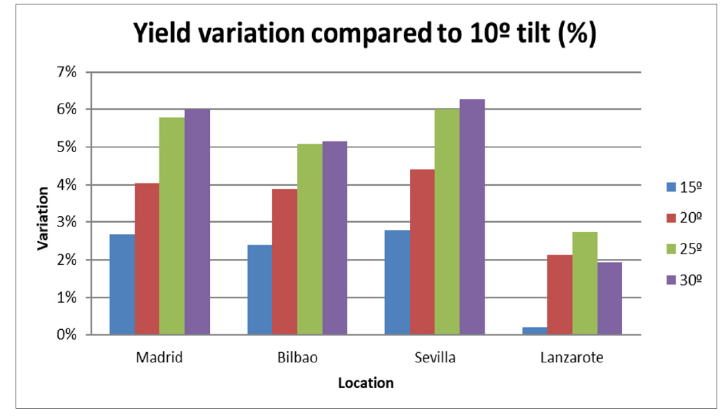
Figure 8. Variation of the Yield with respect to 10º for the studied locations.